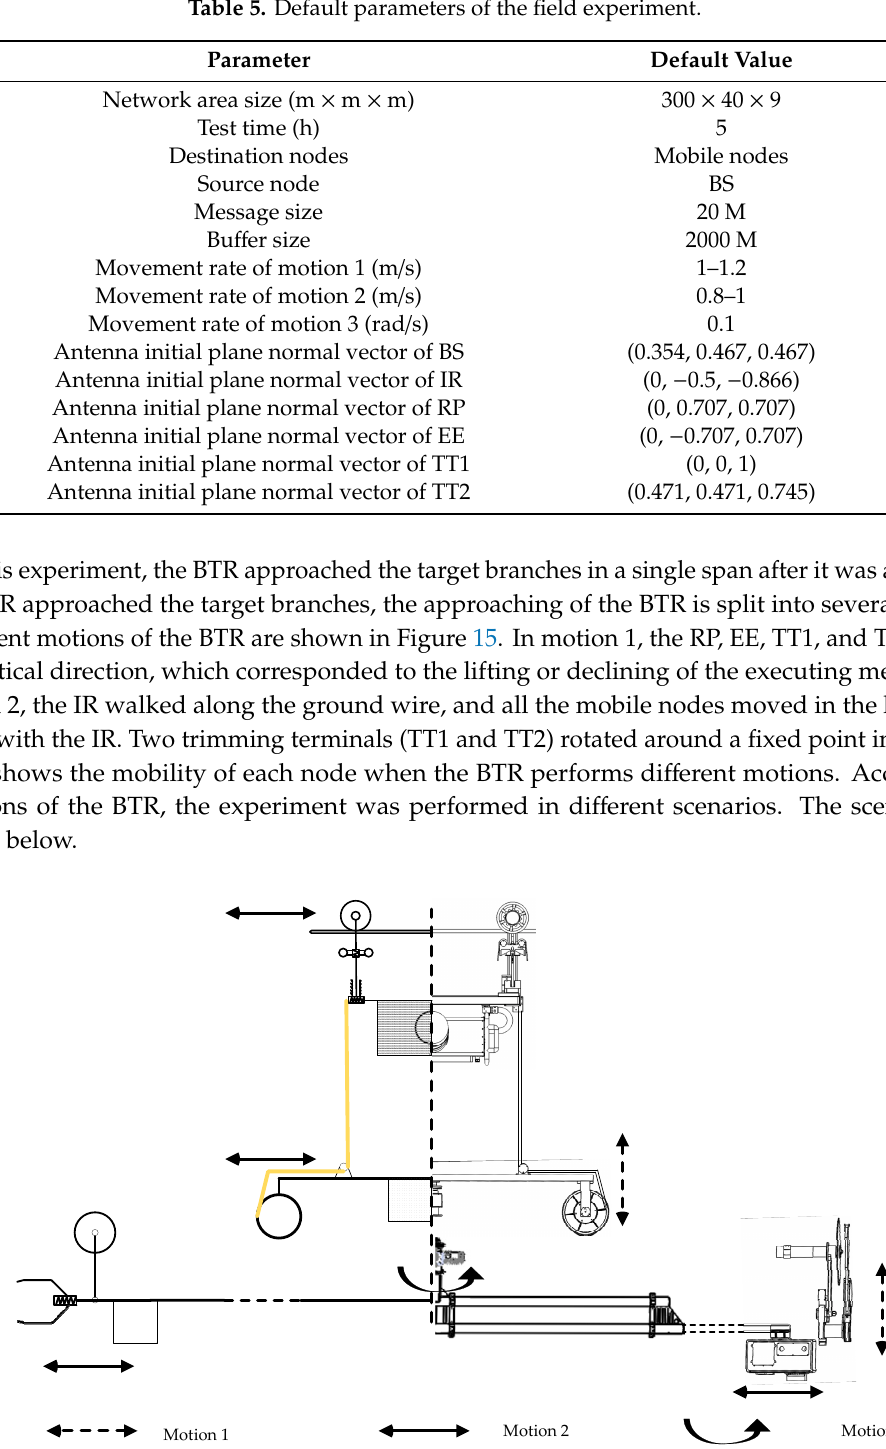
Figure 15. Di ff erent motions of the BTR when the experiment was Figure 15. Different motions of the BTR when the experiment was performed.